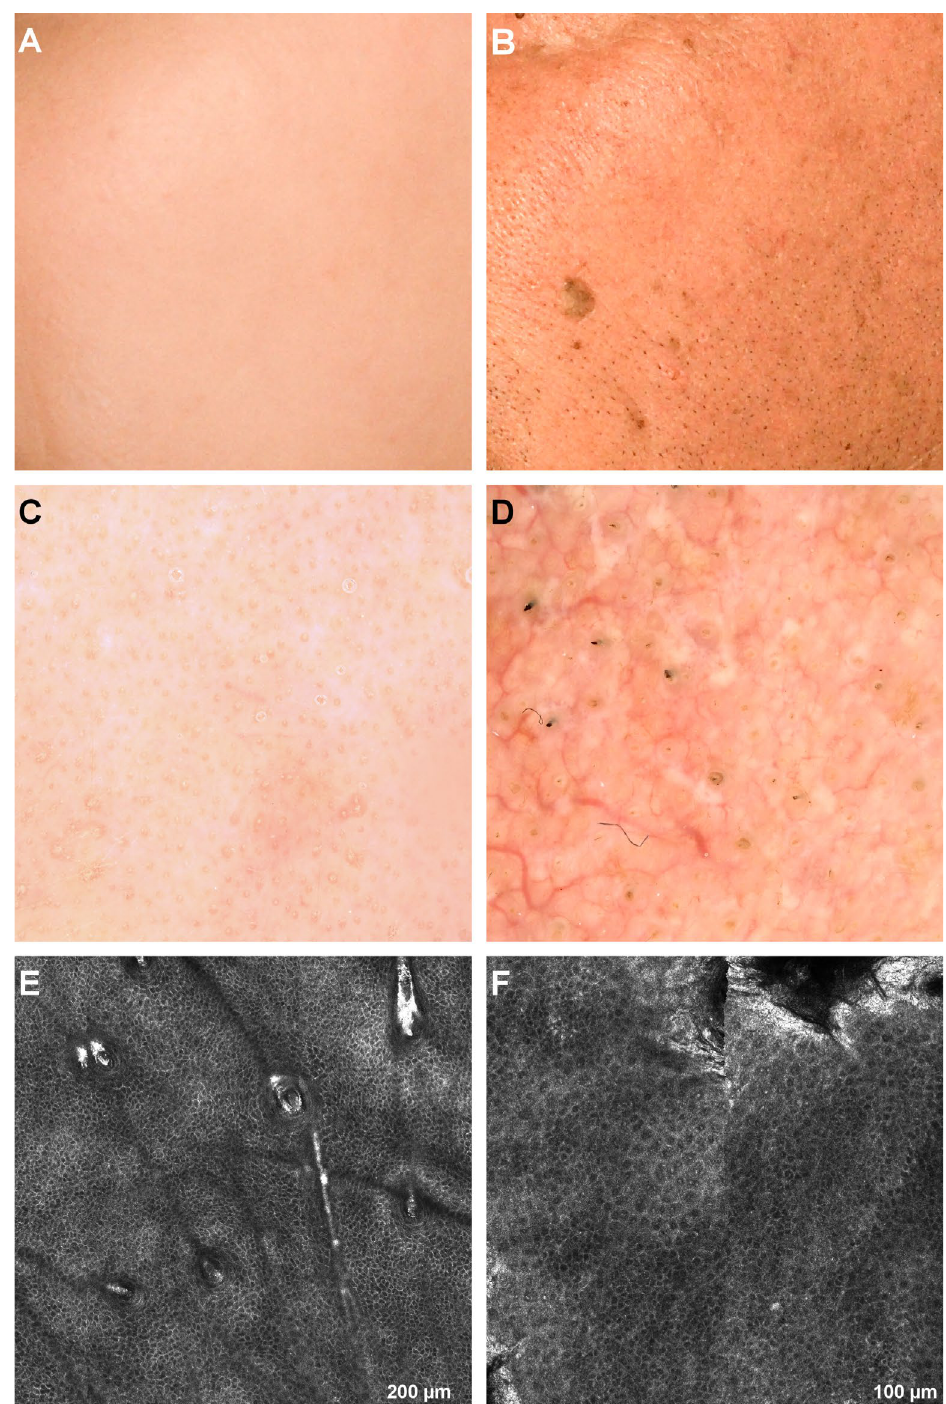
Figure 4. Clinical, dermoscopy, and confocal microscopy (RCM) images of honeycomb patterns. ( A ). Clinical image of left cheek skin of a 32-year-old female. ( B ). Clinical image of left cheek skin of a 76-year-old male. ( C ). Dermoscopy image of the patient in panel A showing visible pores but otherwise no noticeable alterations. ( D ). Dermoscopy image of the patient in panel B showing noticeable mottled pigmentation and several longitudinal, dilated vessels. ( E ). RCM mosaic revealing a regular honeycomb pattern in the 32-year-old female. ( F ). RCM mosaic displaying an irregular honeycomb pattern in the 76-year-old